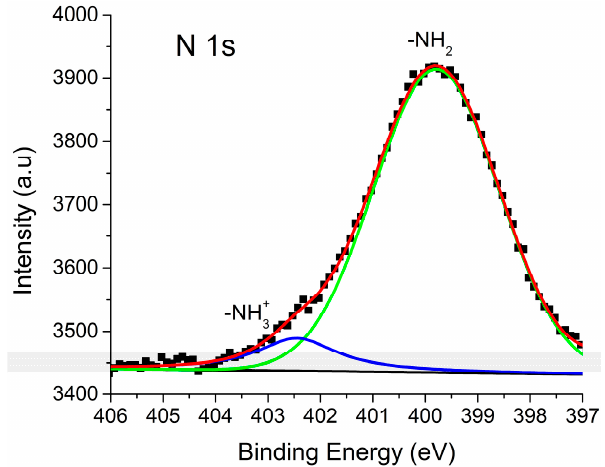
Figure 3. High-resolution XPS spectra with peaks that correspond to the binding energies of nitrogen 1s electrons of OA in a sample of α -CD IC crystals with adhered AuNPs. The original spectrum (black dots lined with red) and the fitted curves (green line assigned to the -NH 3+ group and blue line assigned to the -NH 2 group) are shown. The XPS general spectrum is shown in the Supplementary Materials.